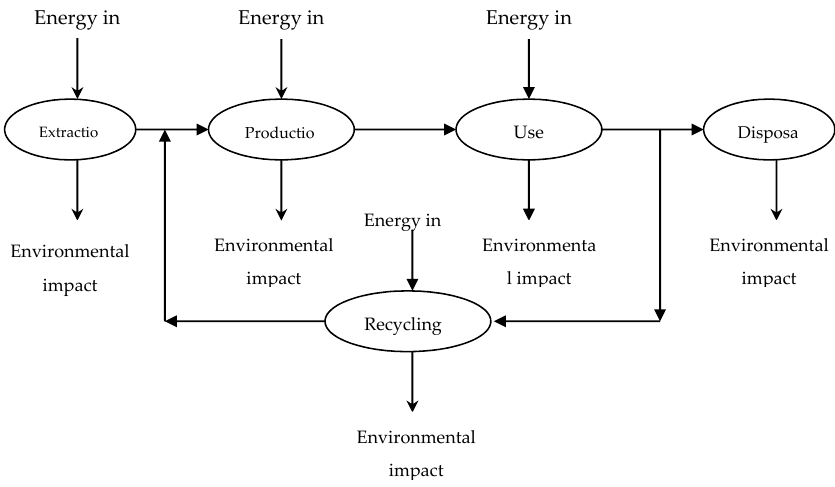
Figure 1. Basic life cycle of a material highlighting the ‘cradle to grave’ approach.